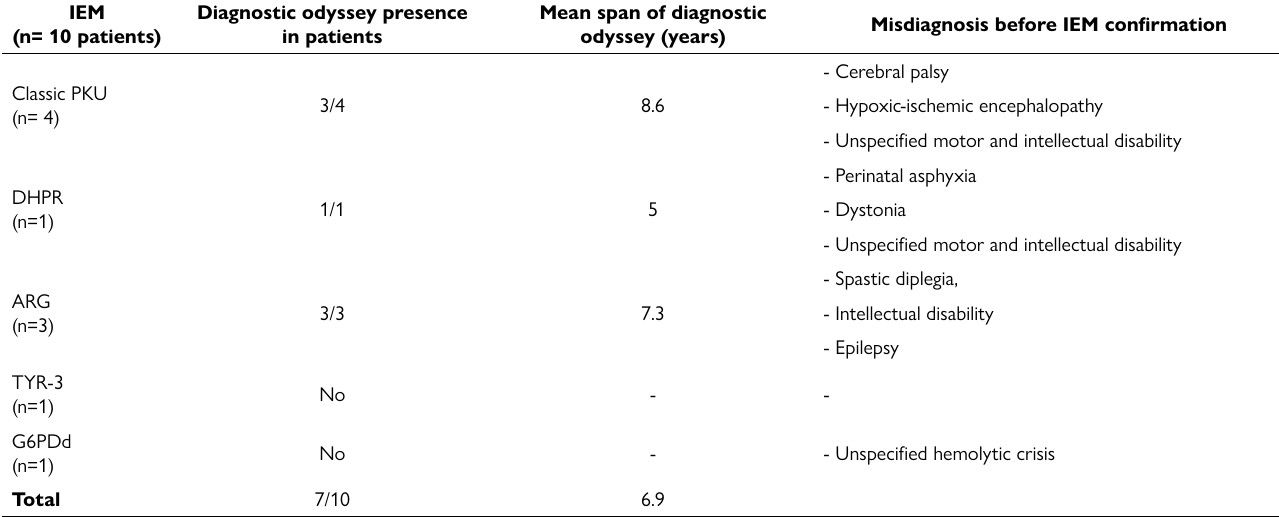
Table 3. Characteristics of the diagnostic odyssey and misdiagnosis of the symptomatic siblings with IEM. IEM (n= 10